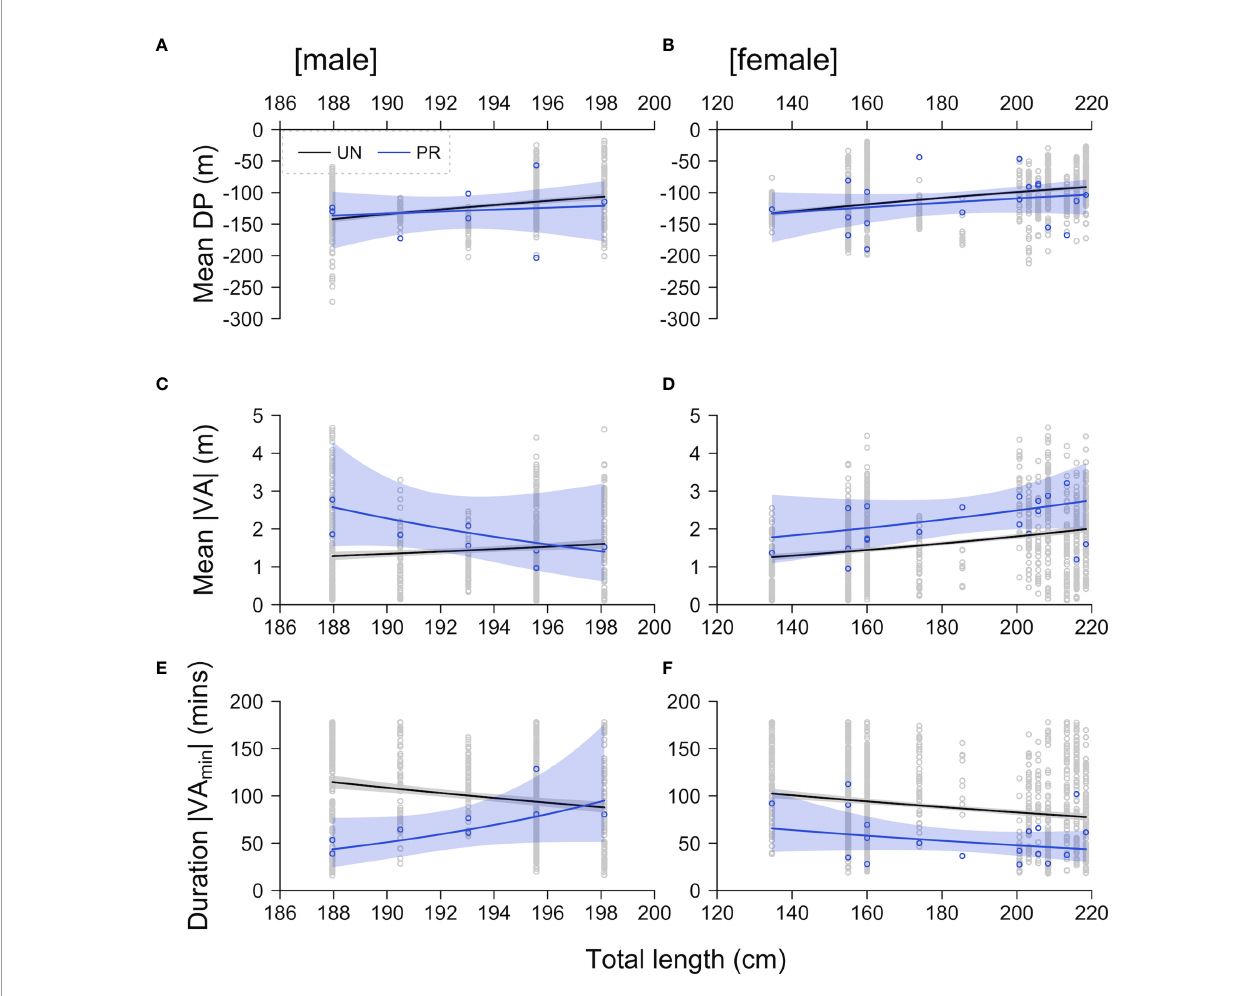
FIGURE 5 | Predictions of the mean depth (A, B) , mean absolute vertical activity (C, D) and the duration of ‘ minimal ’ ( ≤ 0.5 m) absolute vertical activity (E, F) for males (left-hand side: A, C, E ) and females (right-hand side: B, D, F ) in ‘ undisturbed ’ (UN, grey) and ‘ post-release ’ (PR, blue) 12-hour samples with total length. Points mark observations and the lines and surrounding envelopes mark model predictions and 95% con fi dence intervals. In all plots, temperature is held at the mean (scaled)